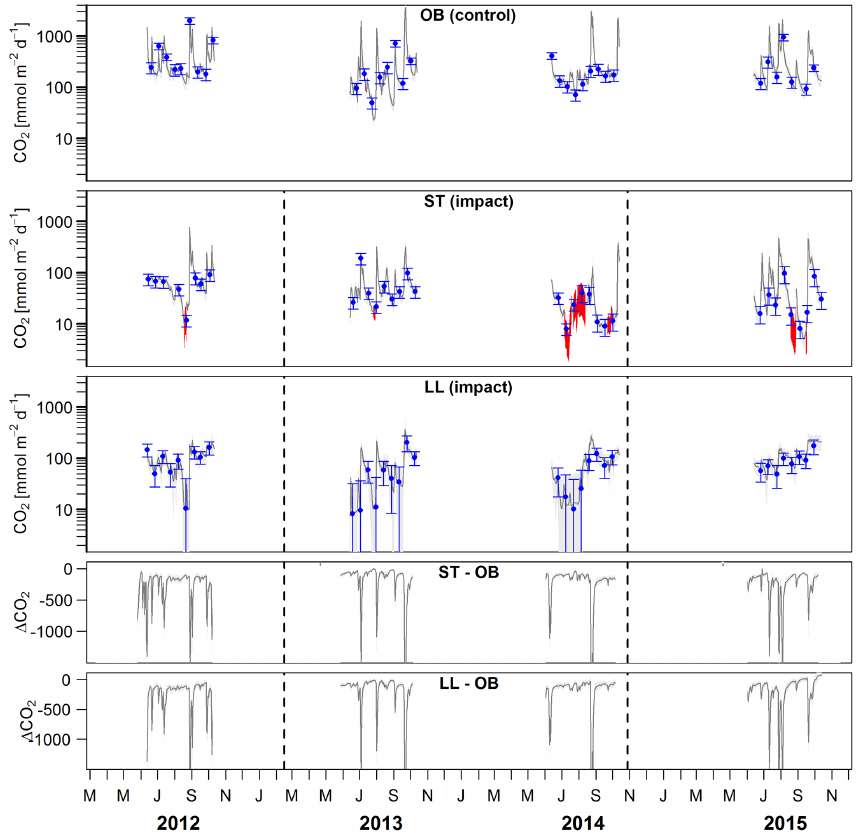
Figure 5. Time series of stream–atmosphere CO 2 fluxes based on daily means of 2-hourly concentration measurements (dark grey lines) and biweekly spot measurements ± standard errors (blue dots and error bars). Given are absolute fluxes and differences ( (cid:49) CO 2 ) between impact and control streams. Shadings and error bars show propagated standard errors (see Fig. S3 and Text S6). Gap-filled data are colored in red. Dashed lines mark the timing of forest clear-cutting (2013) and site preparation (2014). Units are consistent across all panels. Abbreviations: SR is Stortjärn, OB is Övre Björntjärn, ST is Struptjärn, and LL is